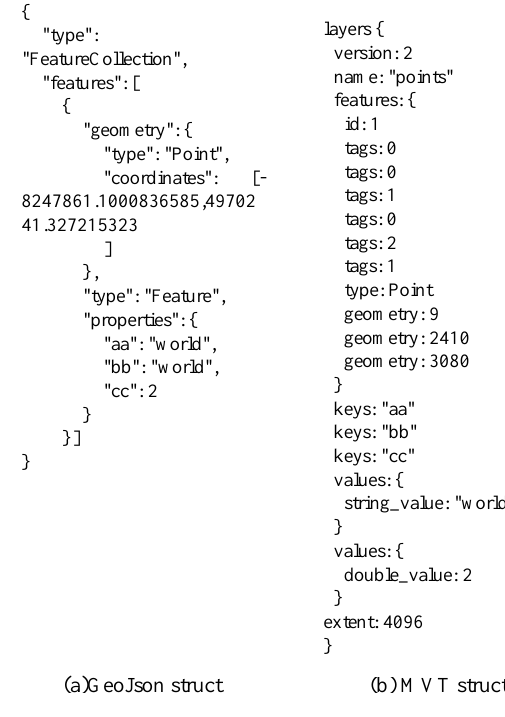
Figure 2 . Examples of GeoJson and MVT